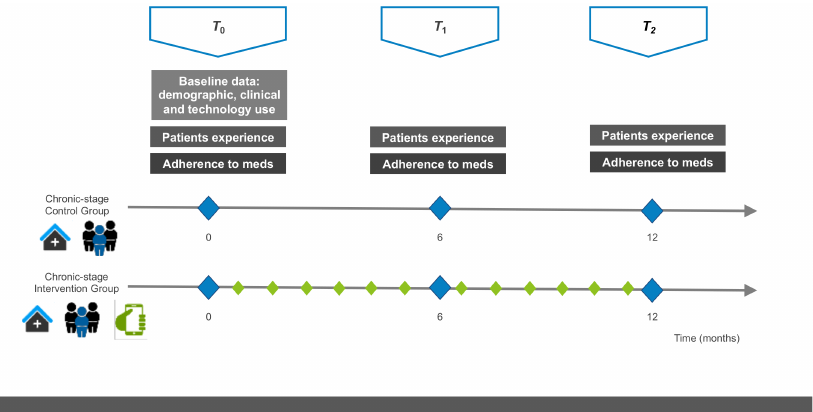
Figure 3. Study design. Scheduled in-clinic visits are shown as triangles: T 0 (baseline at study inclusion), T 1 (at least 6 months after inclusion), T 2 (at least 12 months after inclusion). The variables assessed during scheduled visits are shown as squares: baseline information, patient experience and medication adherence. Treatments are shown as pictograms, i.e., (i) in-clinic visits at the Hospital outpatient department, (ii) multidisciplinary team including the pharmacist and (iii) the mHeart mobile application for remote interaction with the pharmacist. The diamonds show the scheduled interaction with the clinical pharmacist to perform interventions: blue (during the scheduled in-clinic visits; all patients) and green (using the mHeart tool; intervention group